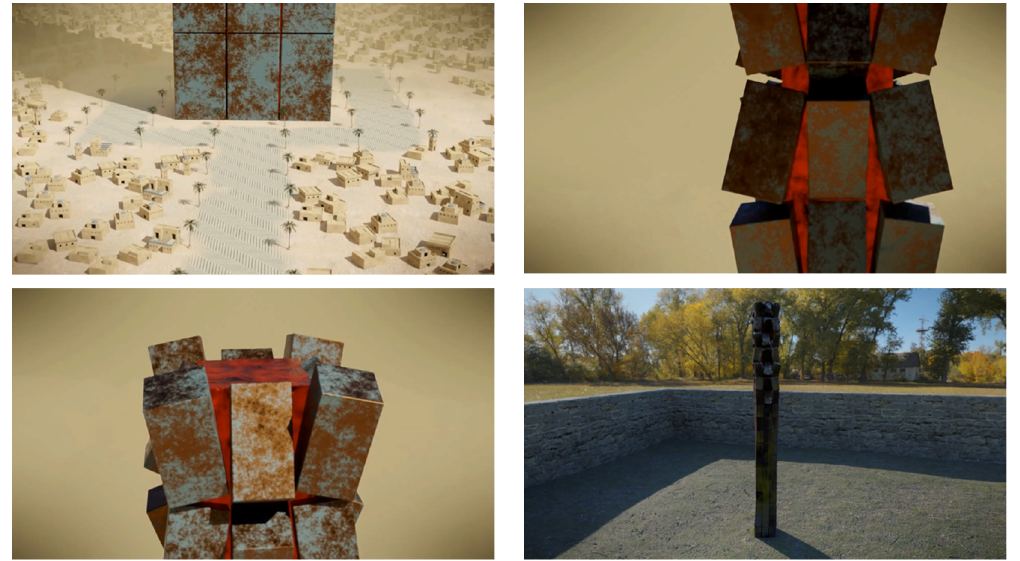
Figure 15. The process of an interpretative approach for creation of 3D animation of the sculpture “Tower of Babel”, Jon Oxman, 1978 (author of 3D animation: Jernej Kalin). “Tower of Babel”, Jon Oxman, 1978 (author of 3D animation: Jernej